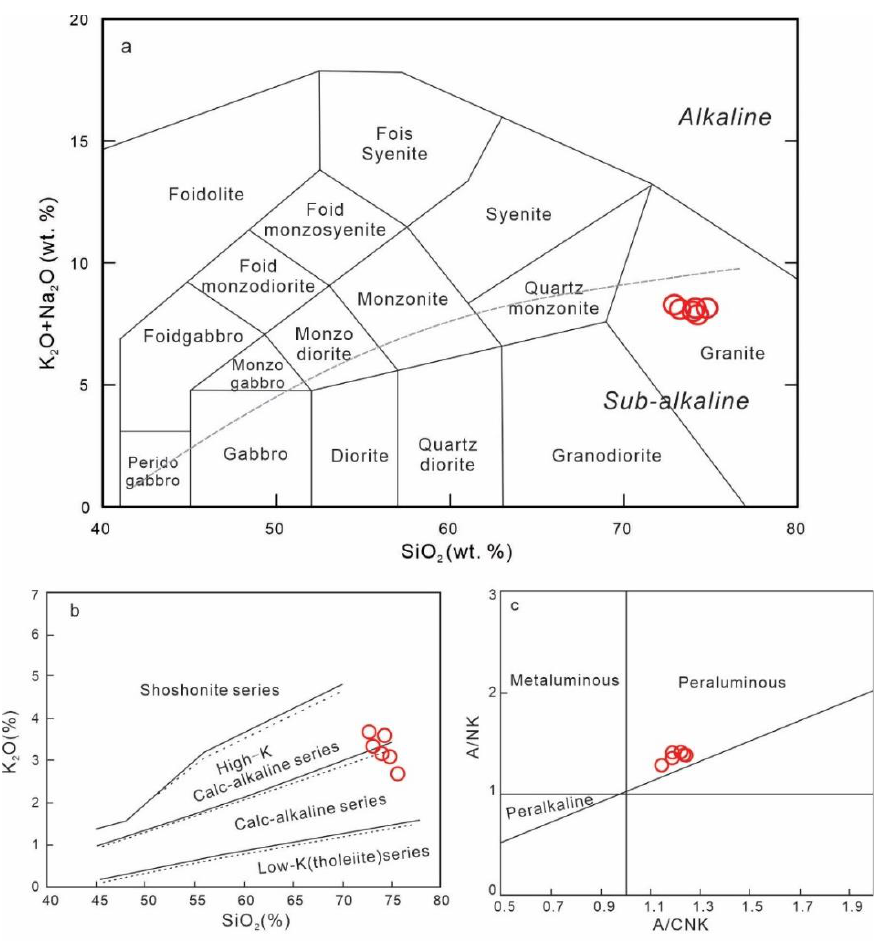
Figure 3. Classification of the samples from Zhaojinggou monzogranite pluton, Inner Mongolia. ( a ) TAS diagram [26]; ( b ) SiO 2 -K 2 O diagram of Zhaojinggou monzogranite, Inner Mongolia [26]; ( c ) A/CNK-A/NK diagram [27].